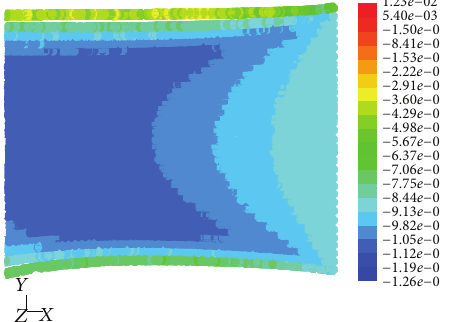
Figure 3: The cross-section of ultrasonic